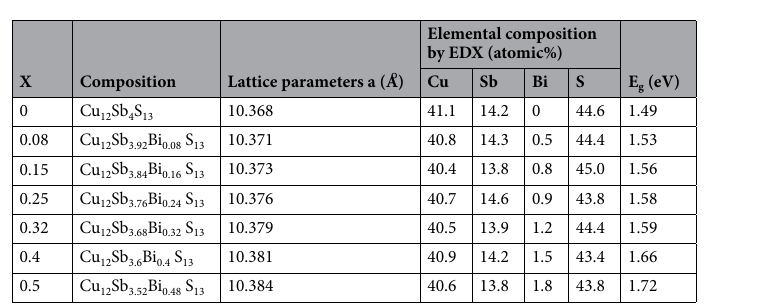
Table 3. Lattice parameters a, EDX compositional analysis and the estimated band gap (E g ) of Cu 12 Sb 4−x Bi x S 13 (x = 0.08, 0.15, 0.25, 0.32, 0.4 and